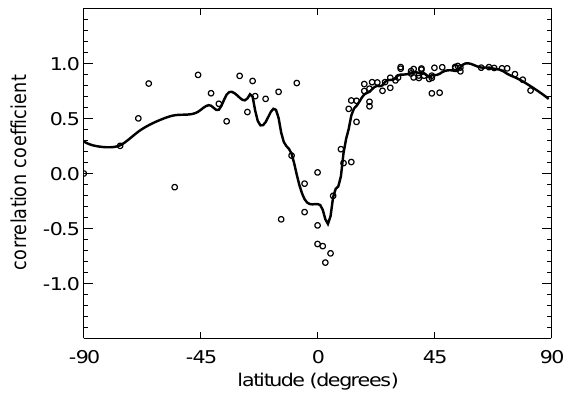
Fig. 9. Latitudinal dependence of the phase synchronicity be- tween the seasonal cycle of atmospheric CO 2 concentrations and the solubility of CO 2 in seawater. Correlation coefficients between observed monthly averaged atmospheric CO 2 concentration sea- sonal cyclicity and the calculated monthly averaged seasonal cycle of CO 2 solubility in seawater are plotted against observation lat- itude. Points relate to all CarbonTracker flask measurement sites containing at least five years worth of data (Peters et al., 2007), as present in http://www.esrl.noaa.gov/gmd/ccgg/carbontracker on 11 August 2010. Atmospheric CO 2 observations were detrended us- ing a third-order polynomial, fitted (using the least squares method) to all observations at each individual site. Detrended data were av- eraged into a typical annual cycle, then the correlation coefficient calculated between the 12 average months of atmospheric CO 2 data and 12 months of latitudinally averaged CO 2 solubility, calculated at the latitude corresponding to the relevant atmospheric CO 2 mea- surement site. CO 2 solubilities in seawater were calculated from World Ocean Atlas 2009 surface temperature and salinity climatolo- gies (Locarnini et al., 2009; Antonov et al., 2009). The solid line de- picts a cubic-spline interpolated 6-point moving average through all of the data. High correlation values indicate that the annual cycles in atmospheric CO 2 concentration and CO 2 solubility in seawater vary in phase at that